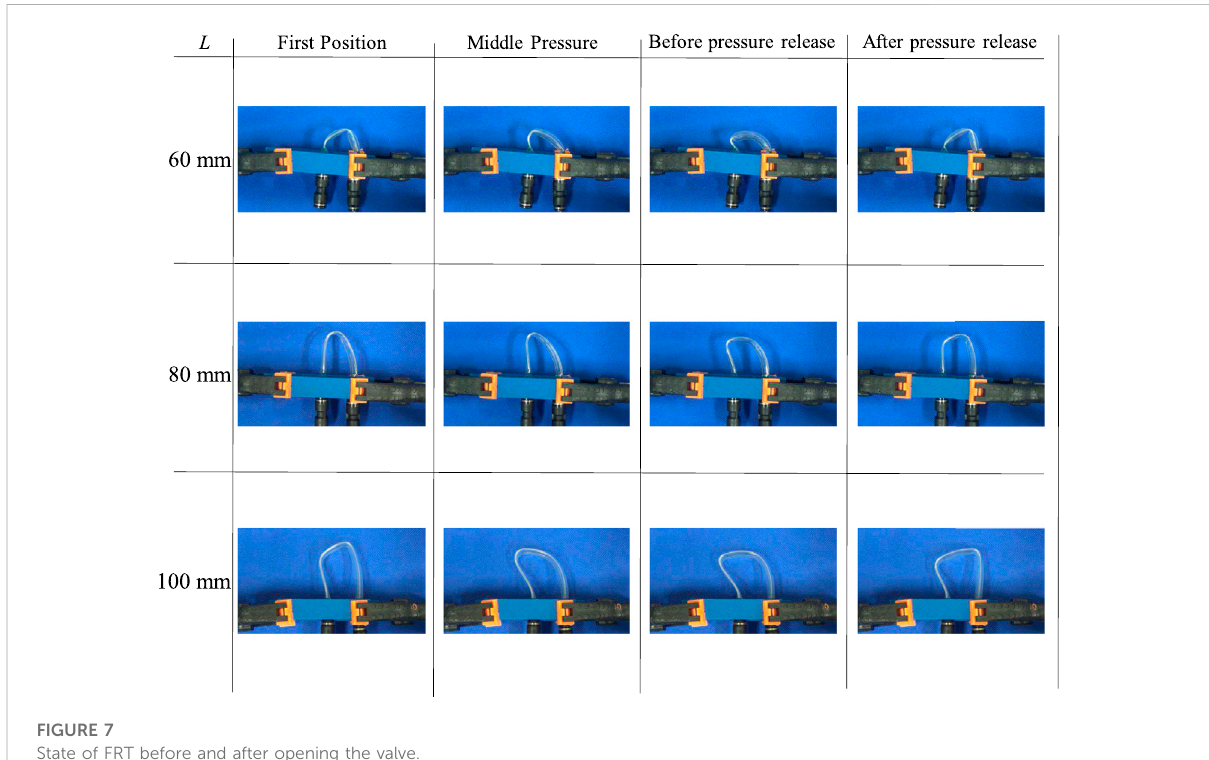
FIGURE 7 State of FRT before and after opening the